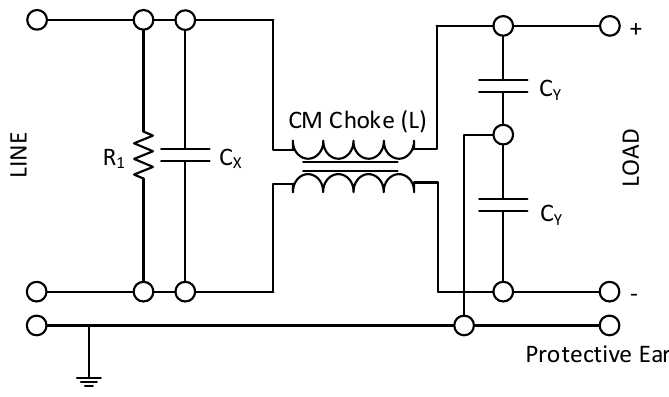
Figure 7. Typical structure of a PLF.